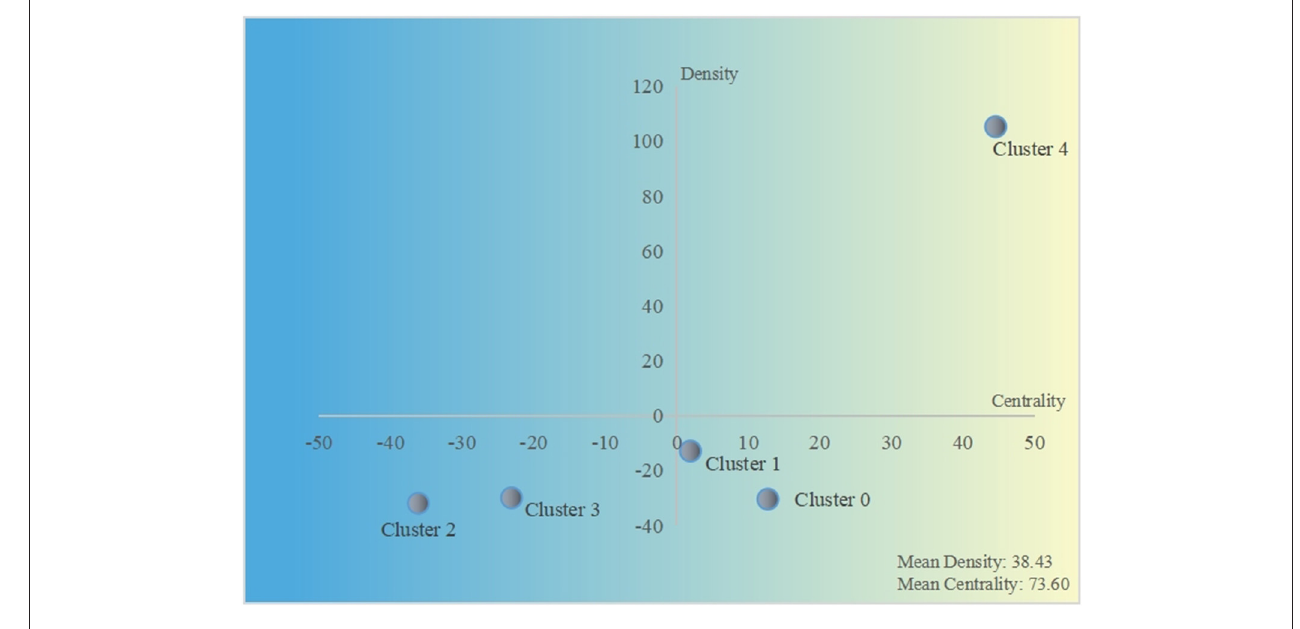
FIGURE 6 | Strategic diagram of 5 clusters.